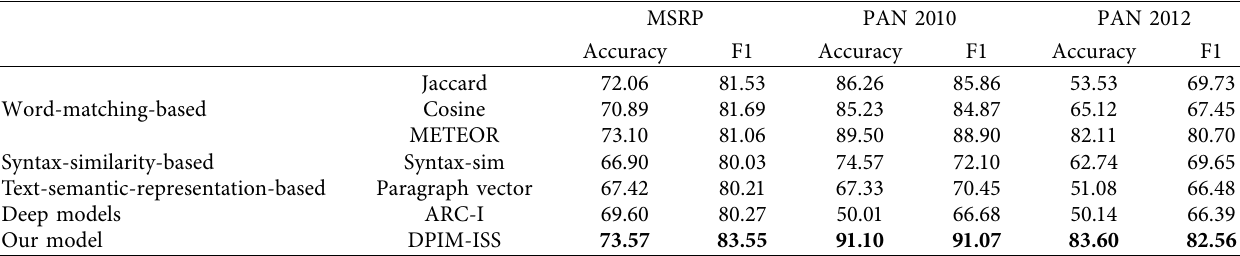
Table 3: Performance comparisons with word-matching-based approaches, the syntax-similarity approaches, the text-semantic-repre- sentation-based deep models, and the CNN-based models.